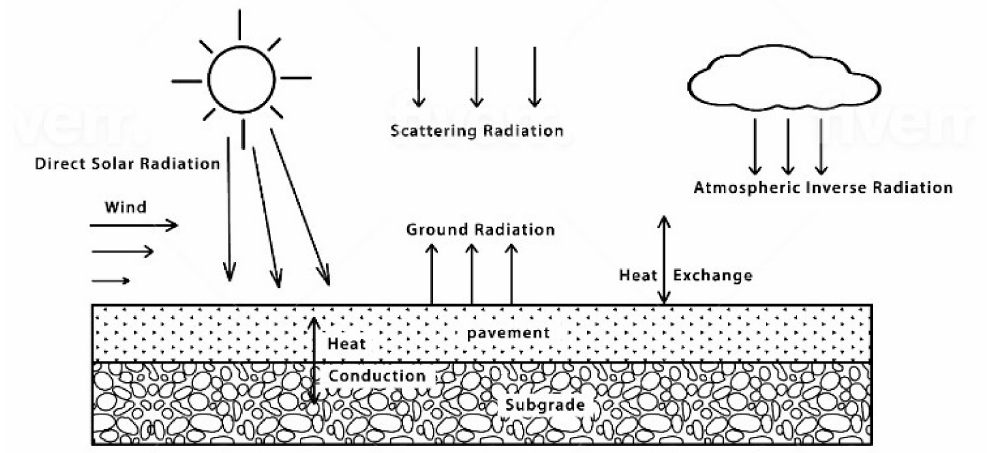
Figure 2. Factors influencing asphalt pavement